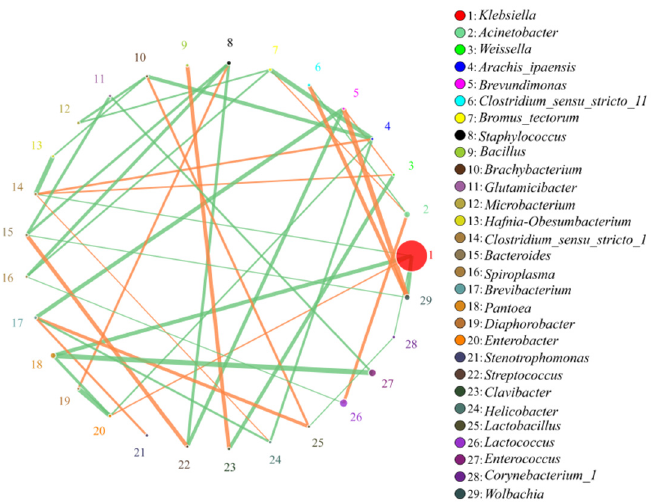
Figure 8. Correlation analysis of microorganisms at the genus level. The circles represented the genera, the size of the circles represented the average abundance, the lines represented the correlation between two species, the thickness and thinness of the lines represented the strength of the correlation, orange represented a positive correlation and green represented negative correlation. The correlation analysis of the top 30 genera in abundances are shown on the right.